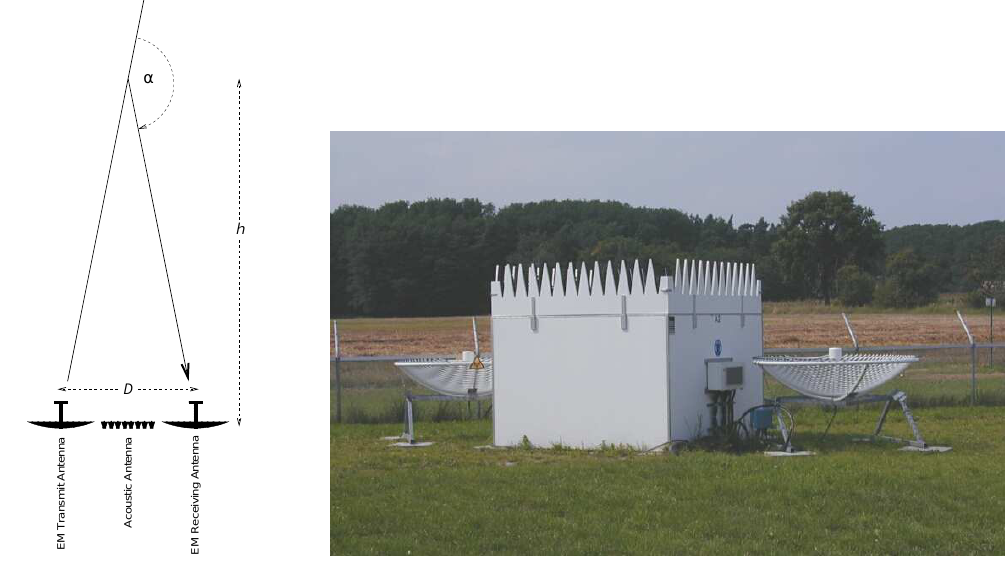
Fig. 1. Bi-static RASS antenna set up. α scattering angle, h measuring height, D distance between electromagnetic transmit and receiving Figure1:Bi-stati RASSantennasetup. transmitandre eivingantennas.